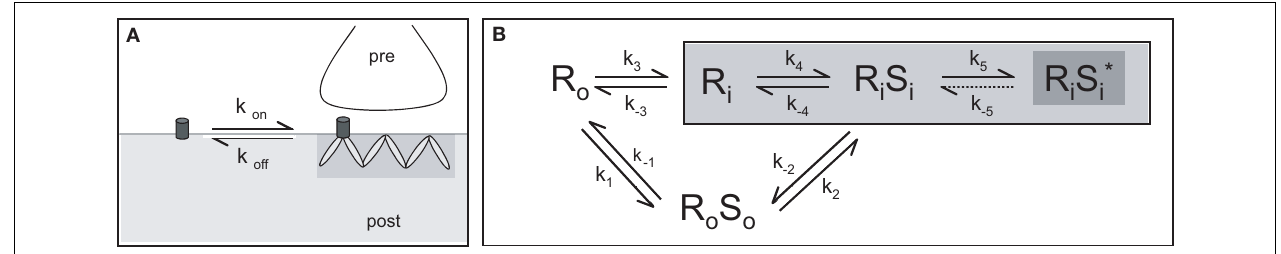
FIGURE 5 | Model of receptor diffusion and stabilization at synapses. (A) Receptor exchanges between extrasynaptic and synaptic domains. The rates of entry and exit from gephyrin clusters defi ne the k (B) Representation of the different paths leading to the stabilization of GlyR by gephyrin clusters. Association of receptor (R) and its scaffolding protein gephyrin